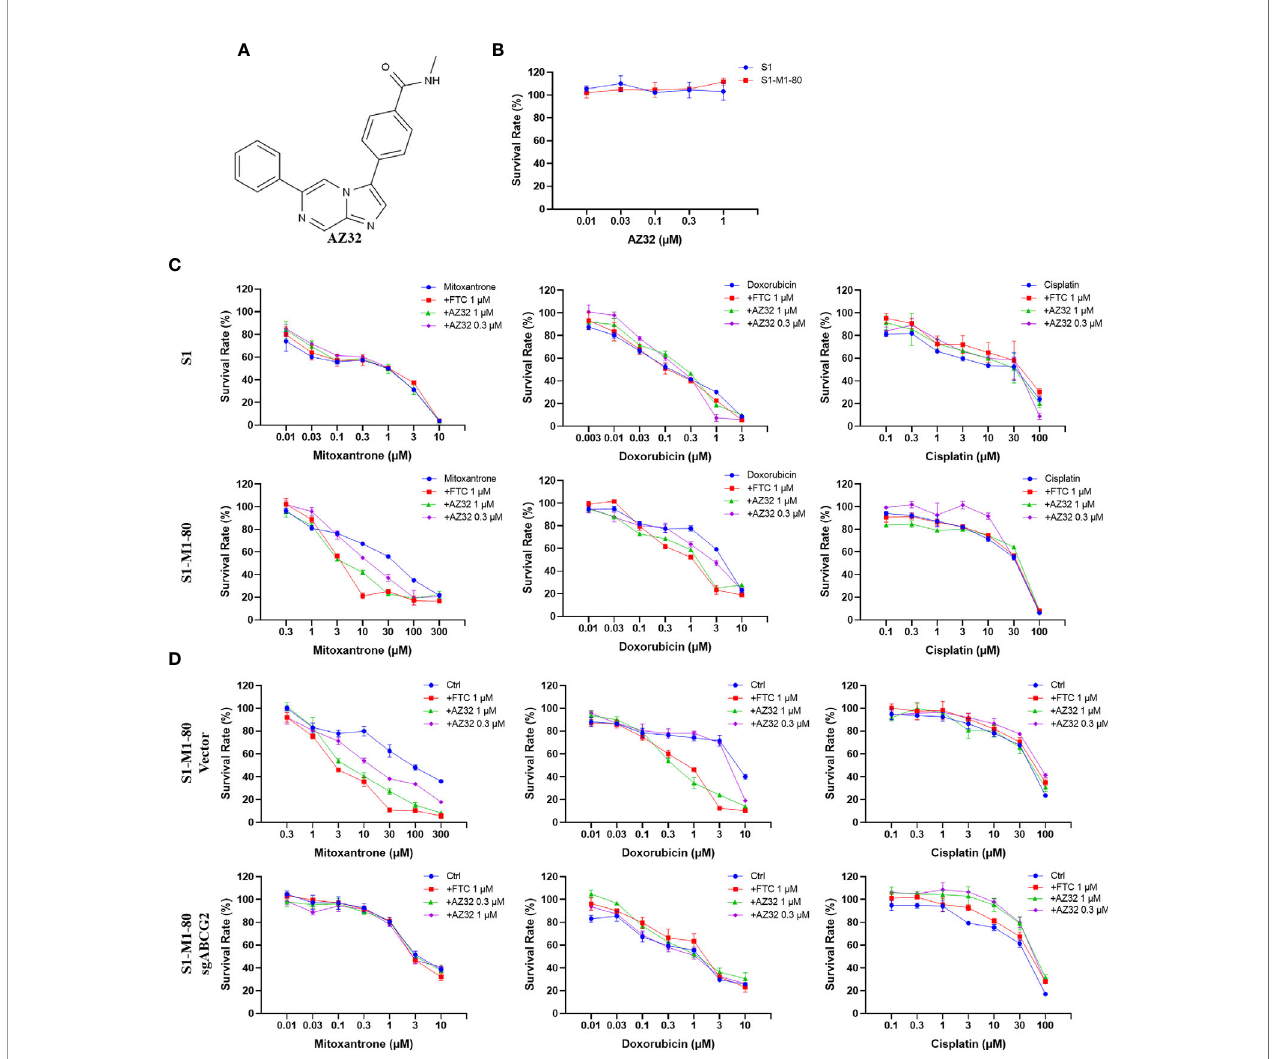
FIGURE 2 | AZ32 sensitized ABCG2-overexpressing colorectal cancer cells to ABCG2-substrate chemotherapeutic drugs. The chemical structure of AZ32 is shown (A) . Cells were treated with the indicated concentrations of AZ32 or other agents for 72 h, and cell survival was measured by MTT assay. The representative growth curve of cells treated with AZ32 alone (B) or in combination with mitoxantrone, doxorubicin and cisplatin (C, D) are